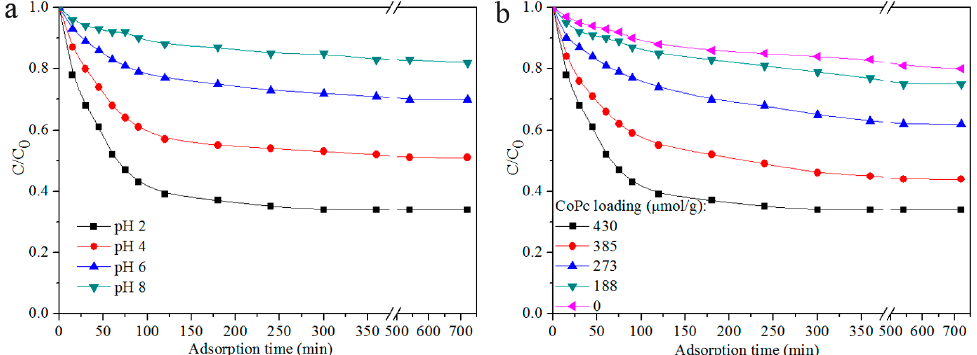
Figure 6. Concentration changes of reactive red X-3B (initial concentration: 1 × 10 − 4 mol/L, T = 50 °C) with CoPc@BC (1.60 mg) adsorption: ( a ) effect of pH; and ( b ) the effect of CoPc loading.